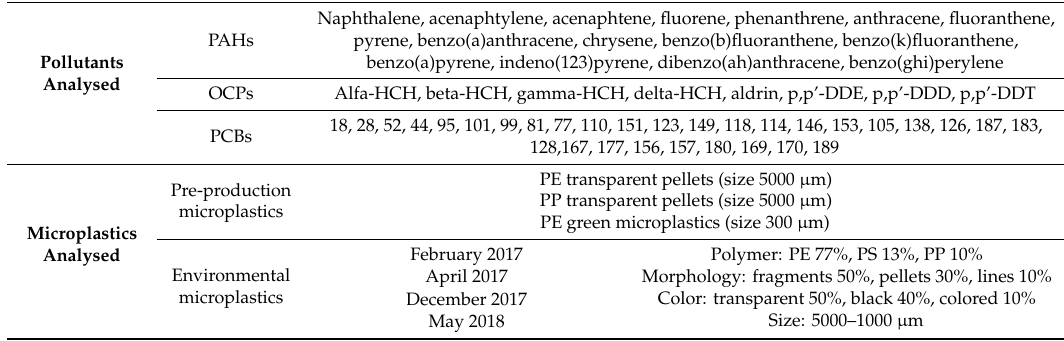
Table 1. Details of microplastic samples and pollutants detected for target compounds analysis by Gas Chromatography–Tandem Mass Spectrometry (GC–MS /